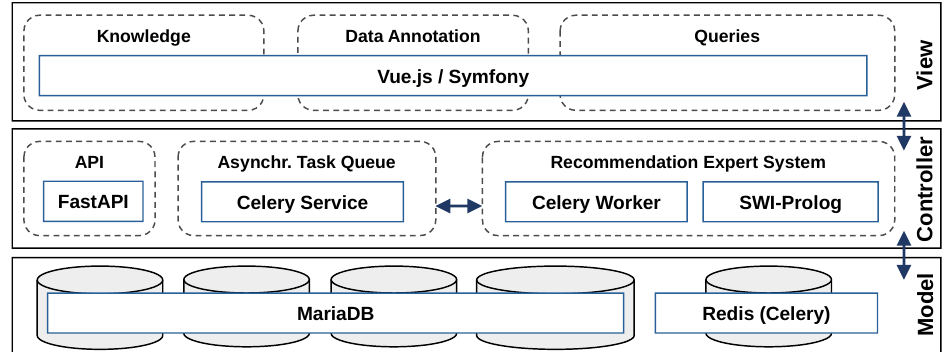
Figure 13. Technical architecture of the proof-of-concept